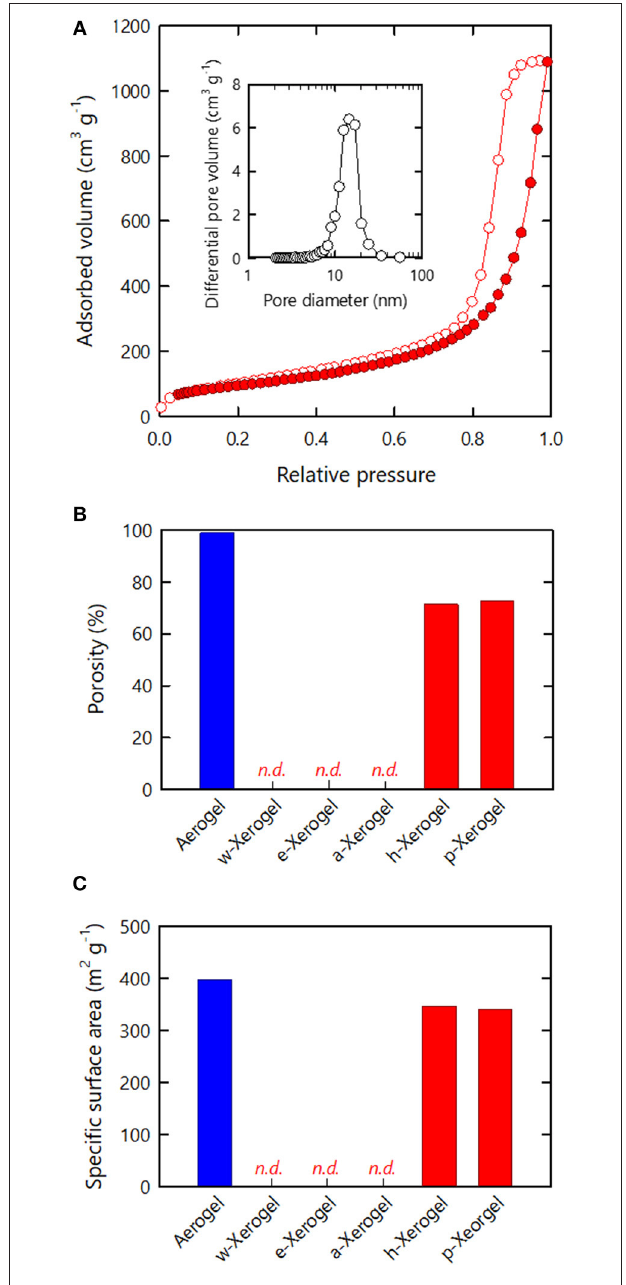
FIGURE 2 | Nitrogen adsorption–desorption analyses of the xerogels. (A) Isotherm of the h -xerogel. Inset shows the pore size distribution estimated from the isotherm. (B) Porosity and (C) SSA values estimated from the isotherms of the respective xerogels.